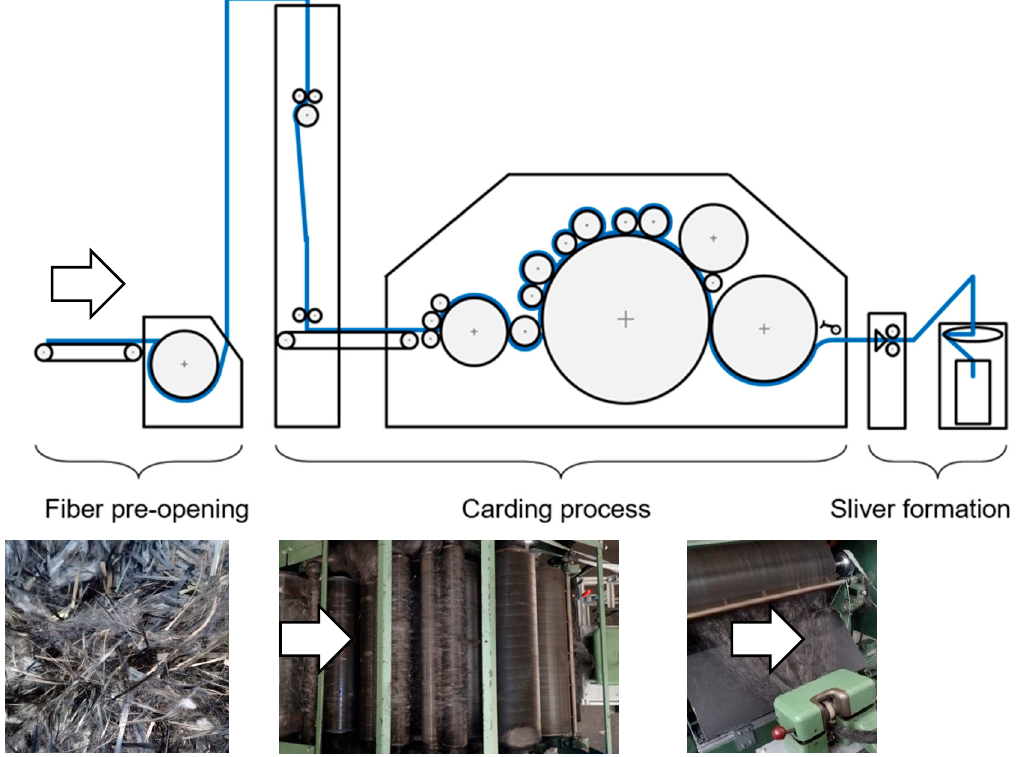
Figure 4. Schematic illustration of the textile process steps used in this study for sliver production ( top ) and pictures of the material feed ( left ), the roller card ( middle ), and the sliver formation ( right ).